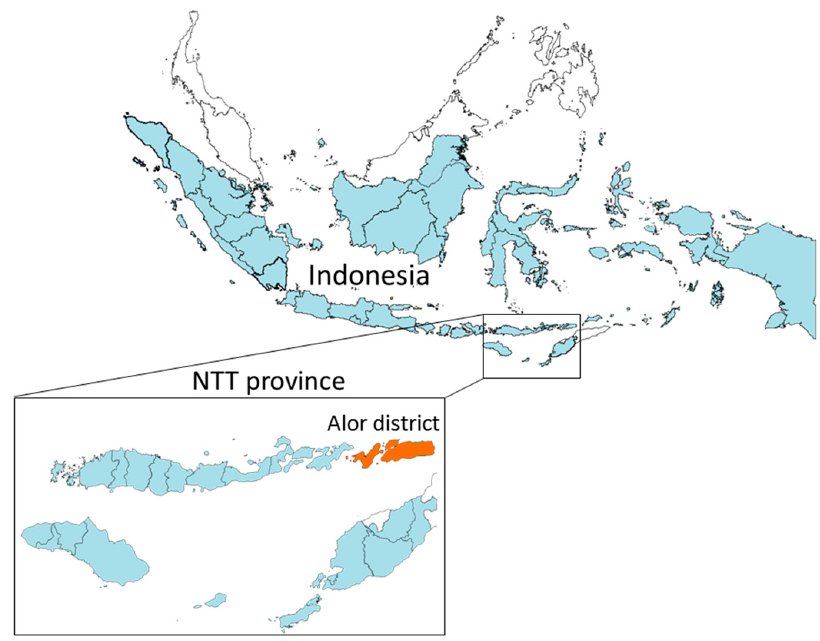
Figure 1. Overview map of Indonesia and the study area (Alor district, Nusa Tengara Timur (NTT) province).